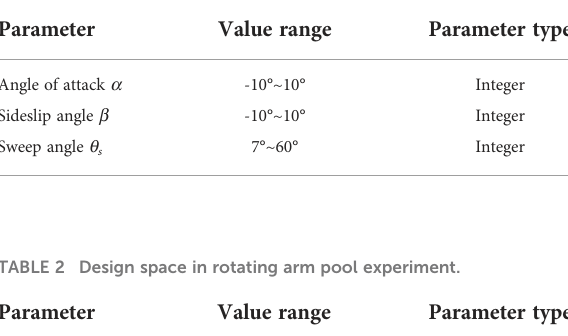
TABLE 1 Design space in fl ume experiment.